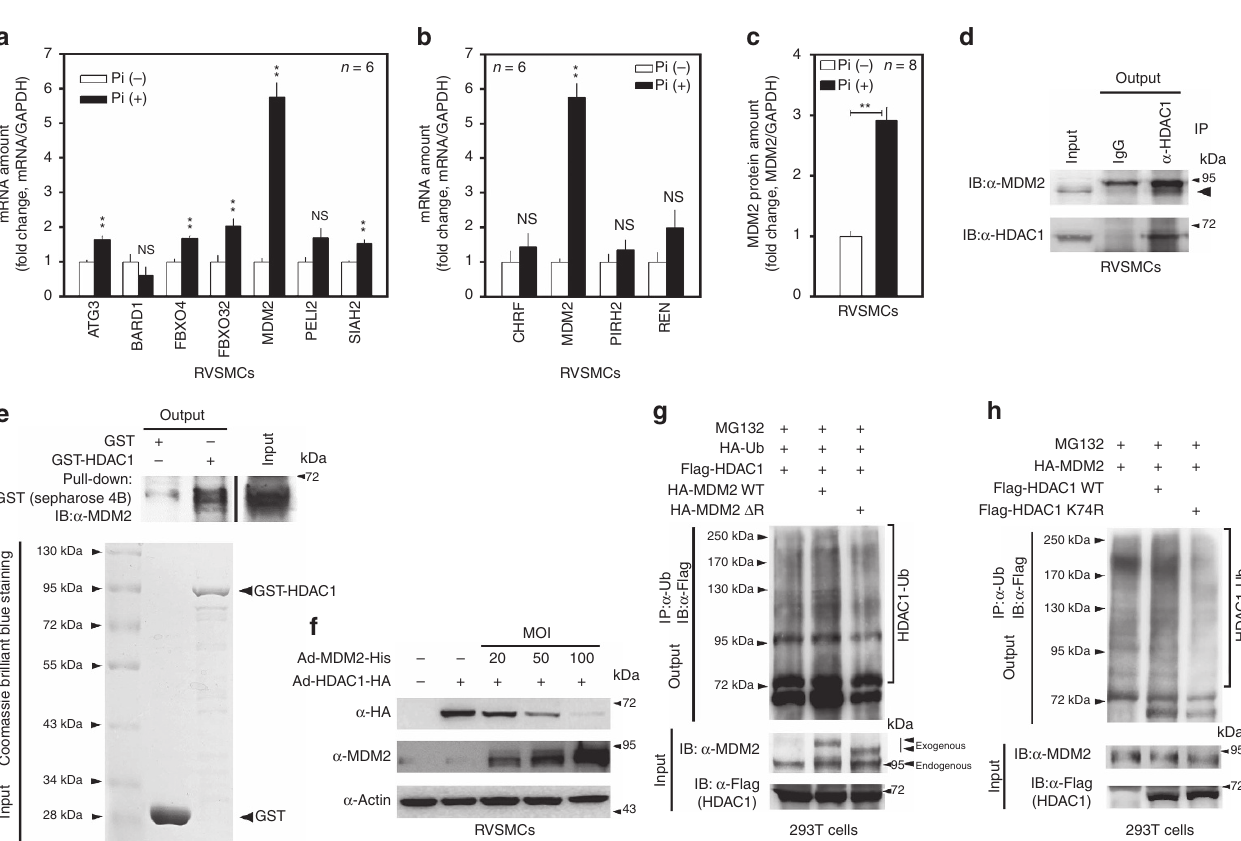
Figure 5 | MDM2 E3 ligase induces degradation of HDAC1. ( a ) Pi-induced changes in the mRNA level of seven candidate genes according to cDNA microarray analysis ( n ¼ 6 from two sets). Each sample was measured in duplicate. ( b ) Pi-induced changes in the mRNA level of four candidate genes on the basis of reports in the literature of HDAC1-specific E3 ligases ( n ¼ 6 from two sets). Note that MDM2 was listed among both the cDNA microarray-based candidates ( a ) and the literature-based ones ( b ). ( c ) Pi significantly increased MDM2 protein expression ( n ¼ 8 from two sets). ( d ) Immunoprecipitation analysis showed that endogenous HDAC1 physically associated with endogenous MDM2 in RVSMCs. ( e ) GSTpull-down assay to show the direct interaction between MDM2 and HDAC1. Both GST-HDAC1 and His-MDM2 proteins were generated from E. coli and then utilized for GST pull-down assay. MDM2-His was recruited by Sepharose 4B-bound GST-HDAC1. ( f ) Adenoviral infection of MDM2 induced dose-dependent reduction of HDAC1 protein in RVSMCs. Cells were treated with an equal amount of Ad-HDAC1 (20 MOI) in each case. ( g ) Transfection of wild-type MDM2 to 293T cells enhanced the ubiquitination of HDAC1 (second lane). However, transfection of MDM2 D R that lacked the RING domain for E3 ligase activity failed to do so (third lane). Flag-HDAC1 and HA-Ub with either HA-MDM2 or HA-MDM2 D R were transfected and maintained for 2 days. Cells were treated with MG132 4h before collecting. The cell lysates were immunoprecipitated with Ub and immunoblotted with HDAC1. ( h ) MDM2-induced HDAC1 ubiquitination was attenuated in HDAC1 K74R. Ub assay was performed. ** P o 0.01, NS, not